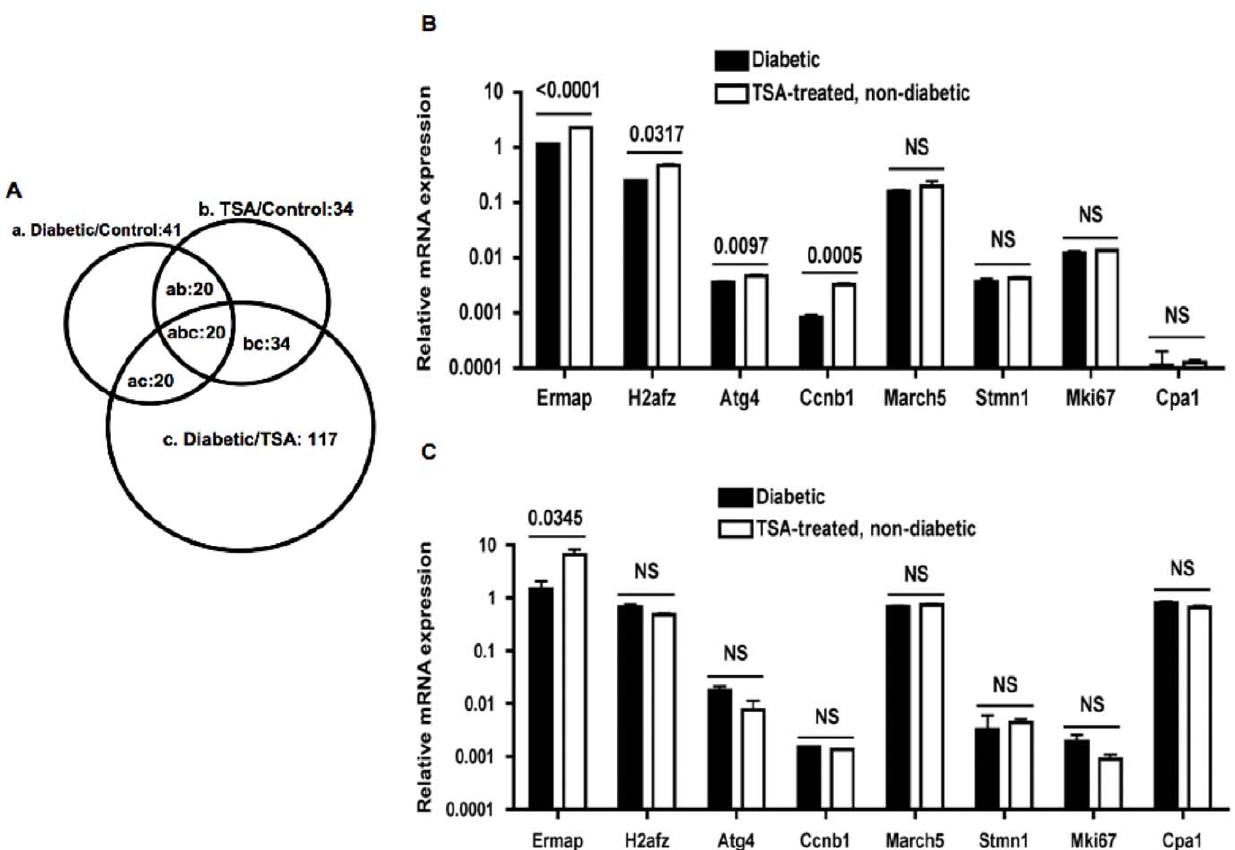
Figure 5. Exaggerated expression of genes in spleens and pancreata of TSA treated mice. ( A ) Area-proportional Venn diagram depicts the distribution of 117 over-expressed genes in TSA treated group (c). Small numbers of genes were also differentially expressed in other combinations (a and b). ( B ) A selected set of genes up-regulated following TSA treatment based on microarray hybridization signals was validated by qRT-PCR using RNA derived from splenocytes of diabetic and cured mice, as described in Figure 4. Total RNA was converted into cDNA and analyzed. ( C ) Gene expression was analyzed using RNA derived from pancreata of overtly diabetic mice and TSA-treated and cured mice. Each data point represents the mean + / 2 SD of triplicate determinations from a representative of 2–3 experiments. In each experiment, RNA was pooled from 3–5 mice. P values between groups are indicated. NS, not significant.